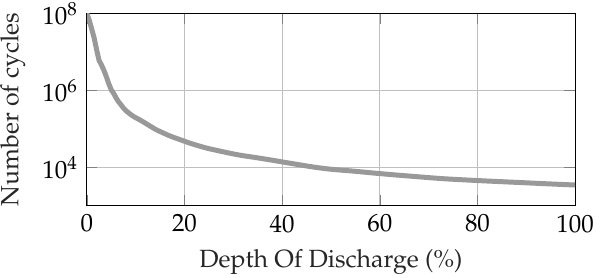
Figure 7. Relation between number of cycles and depth of discharge (DoD) of the